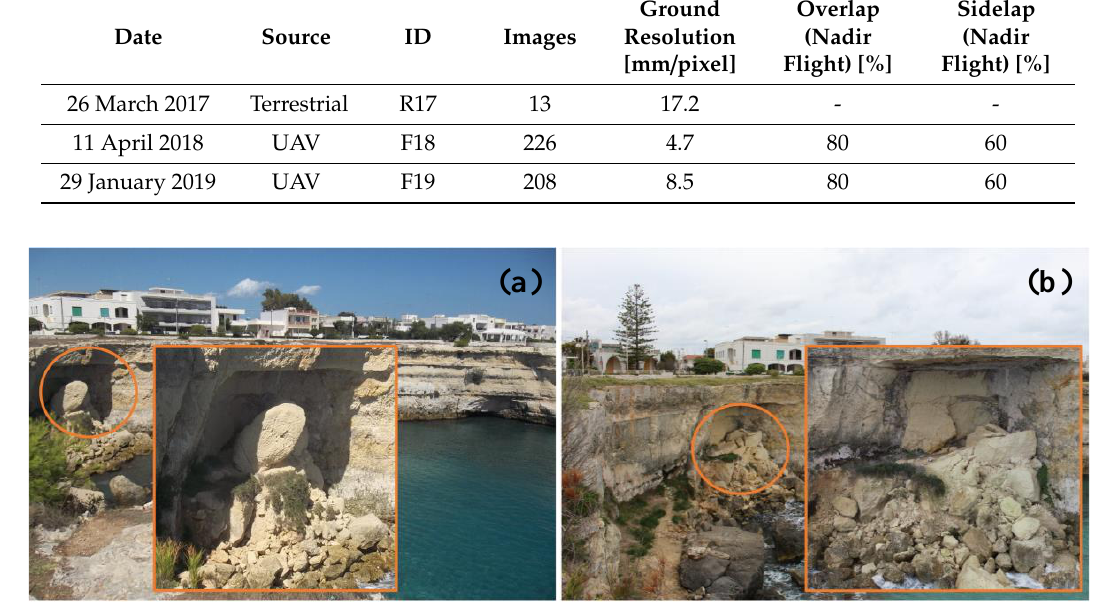
Figure 5. Visual comparison image: ( a ) 2017; ( b ) 2019. The orange circle highlights the block failure, which is zoomed in the orange square. Table 1. Survey campaign characteristics.